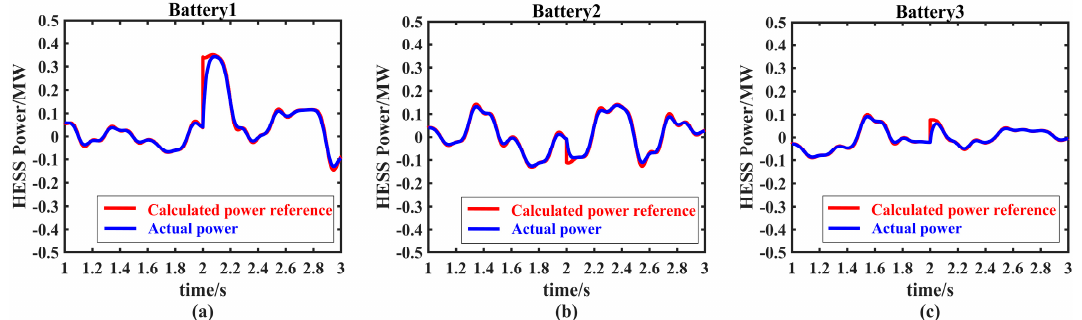
Figure 12. Calculated and actual power of the HESS. ( a ) Battery1; ( b ) Battery2; ( c ) Battery3.